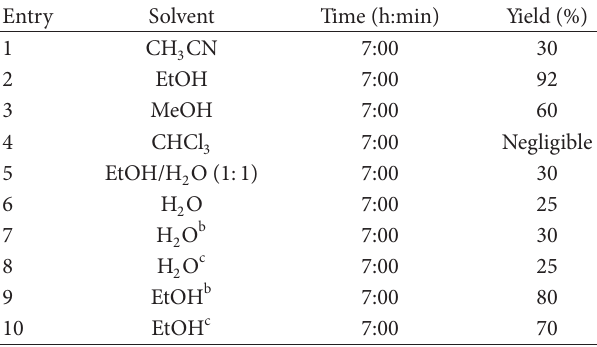
T 2: Synthesis of ethyl-6-methyl-4-phenyl-2-oxo-1,2,3,4-tetra- hydropyrim-idine-5-carboxylate in the presence of Al(NO in various solvents under re�ux and solvent-free conditions a .